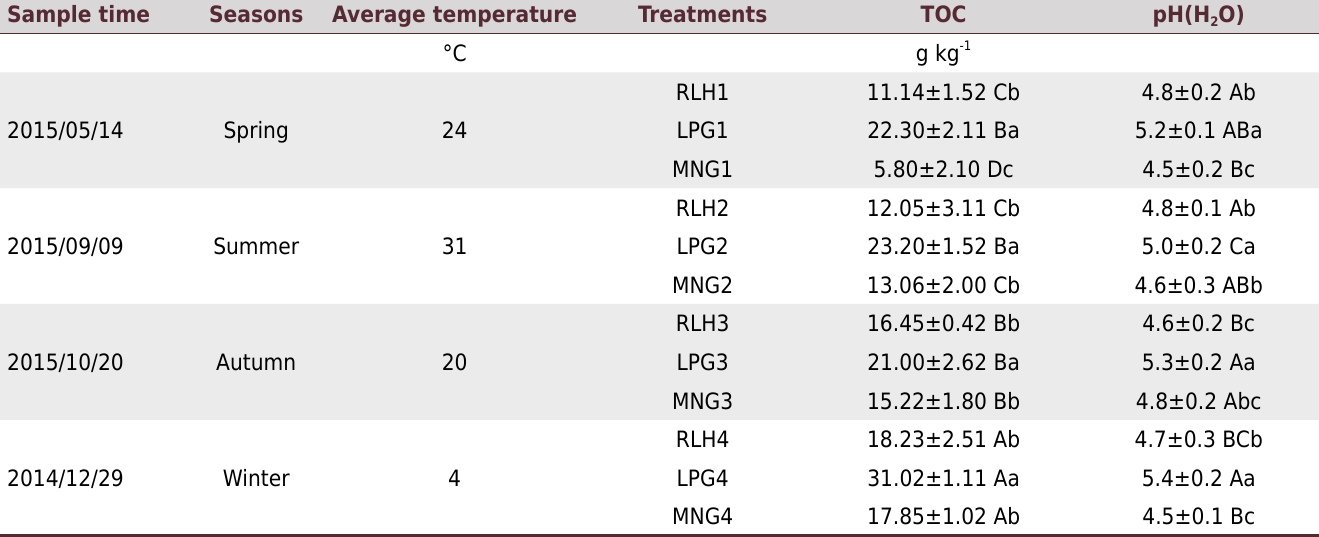
Table 1. Temperature, total organic content (TOC), and pH of soil samples subjected to the following treatments: raising laying hens under forest (RLH), cultivating Lolium perenne grass under forest (LPG), and maintenance of native grass under forest (MNG) collected at four times during the year Sample